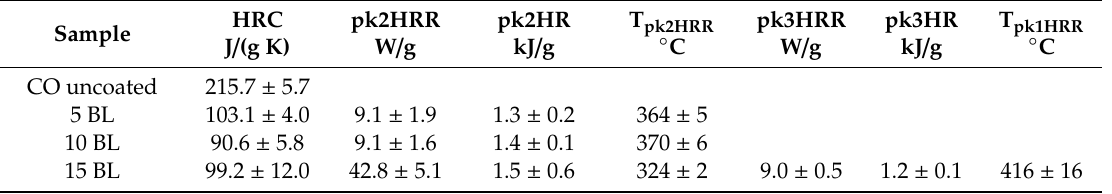
Table A1. Complementary microscale combustion calorimetry data